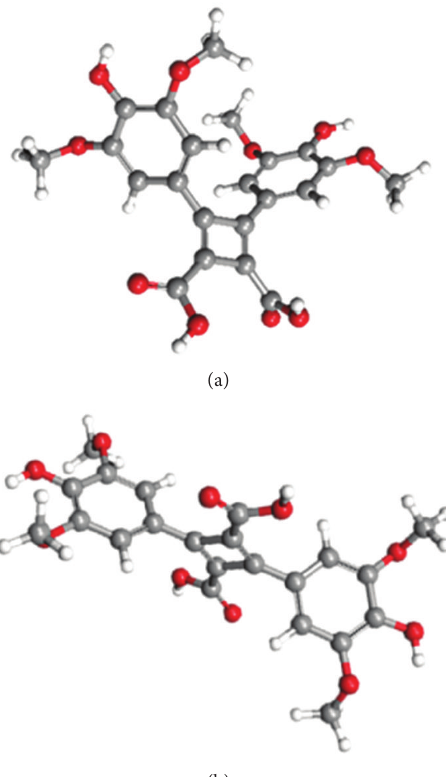
Figure 6: Possible molecular structures of dimmers formed from photodimerization of SinA from (a) head-tail arrange and (b) head- head arrange. Grey balls represent carbons, red balls represent oxygens, and white balls represent hydrogens. The structures were optimized by using the MNDO